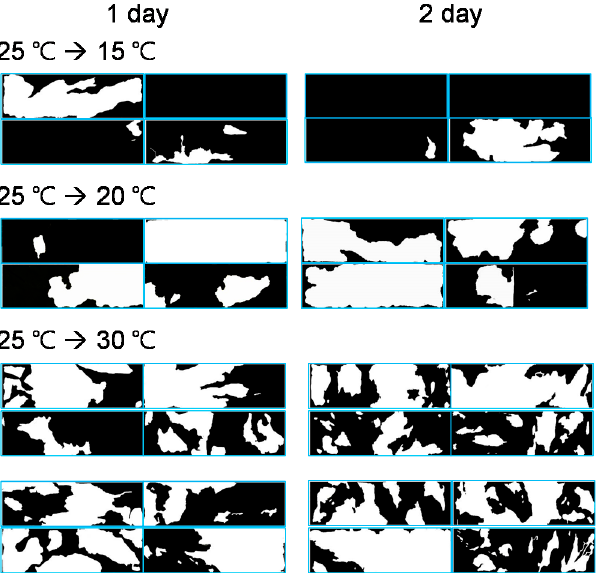
Figure 1. Examples representing the feeding area extracted using digital image processing in Matlab. White color: fed area, and black color: unfed area.